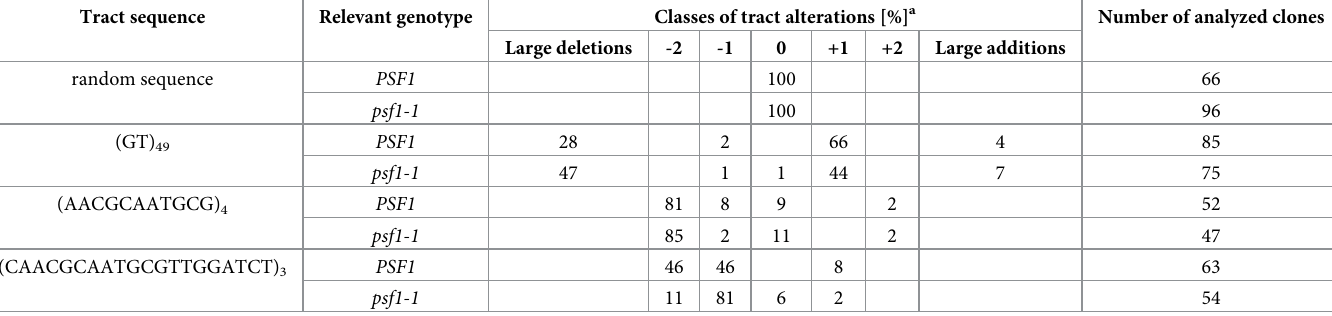
Table 1. Types of alterations within different repeat tracts in the psf1-1 mutant and wild-type strains carrying plasmids with repeat sequences. Tract